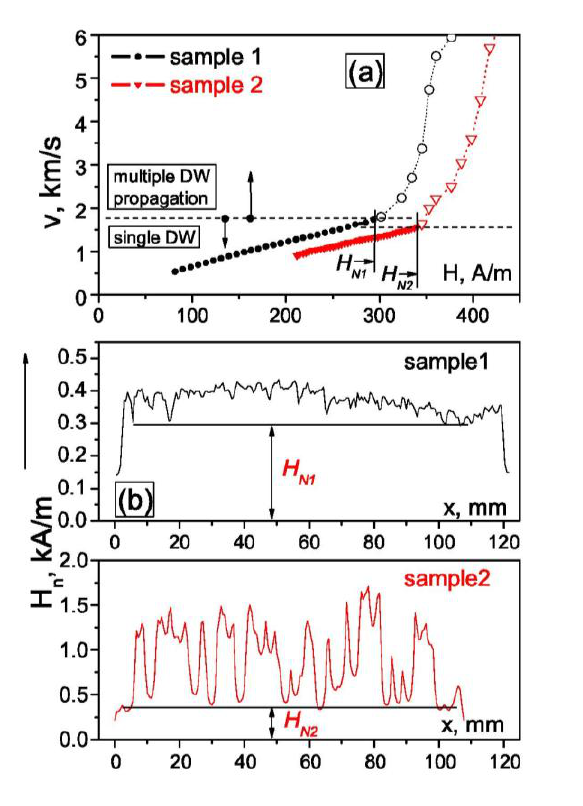
measured in the same n